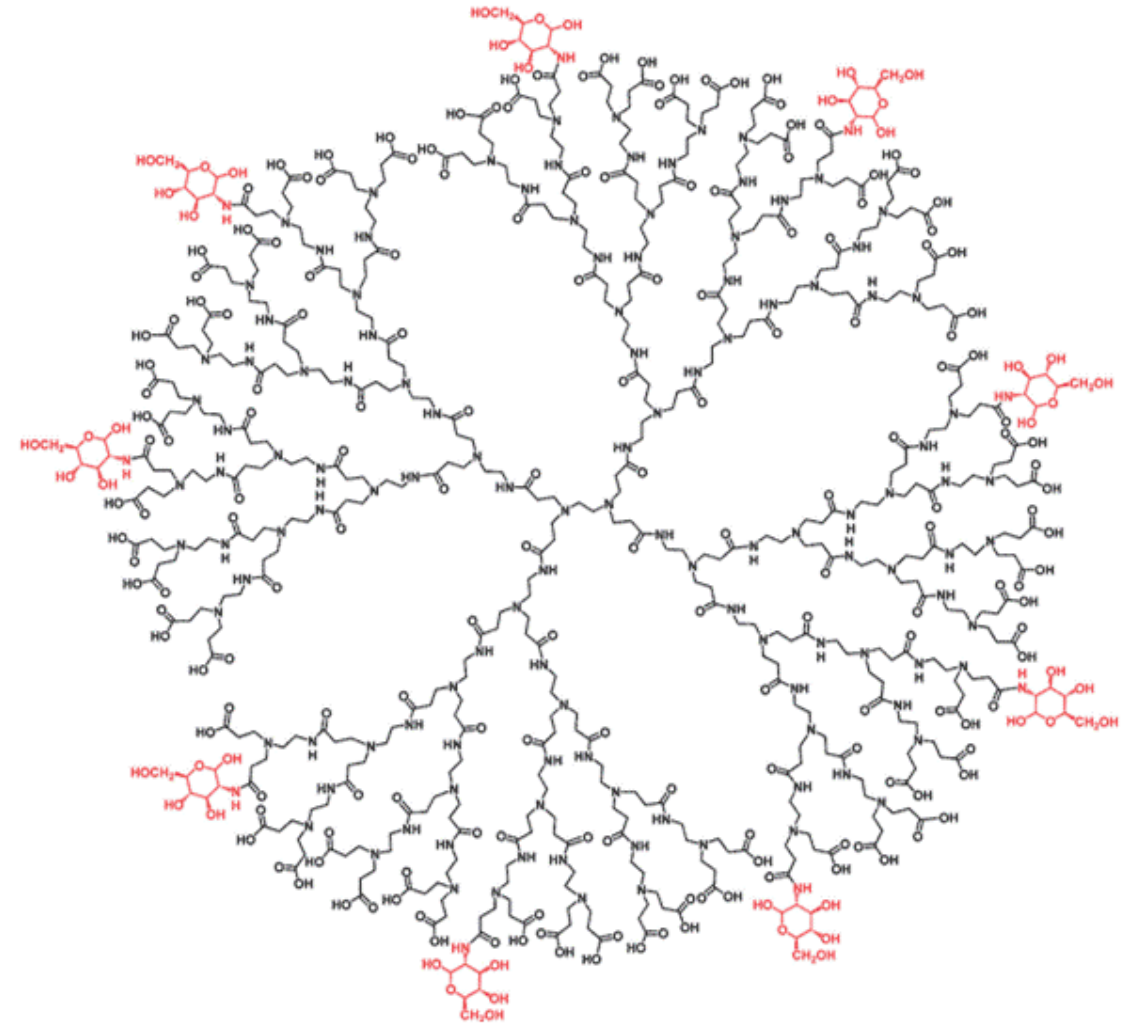
FIGURE 2. Structure of the glyco-conjugated dendrimer DG. In red, the amino-linked glucosamine surface groups. (From Shaunak et al.[33]. © Nature Publishing Group, reproduced with